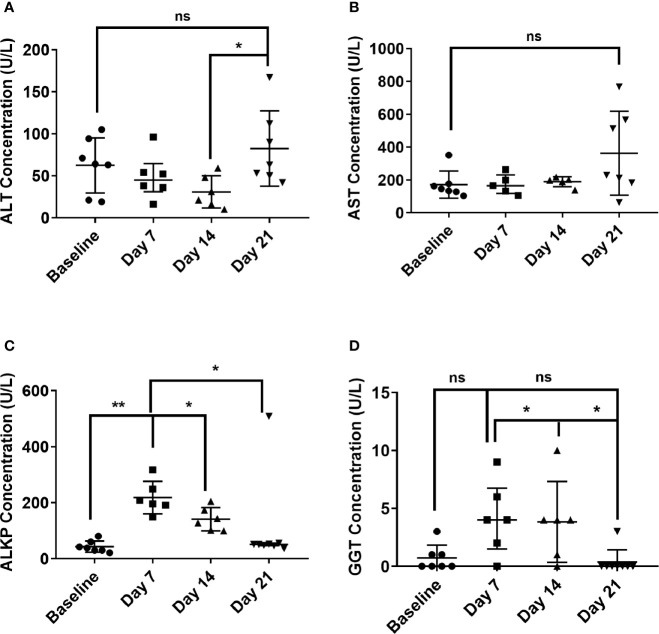
Temporal liver enzymes changes in marmoset blood at day 7, 14 and 21 following inhalational challenge with C. burnetii.
(A) alanine transaminase (ALT), (B) Aspartate aminotransferase (AST), (C) alkaline phosphatase (ALKP), (D) gamma-glutamyl transferase (GGT). Data is median and interquartile range, significance determined by ANOVA; indicated by asterisks * p<0.05, and **p<0.01.